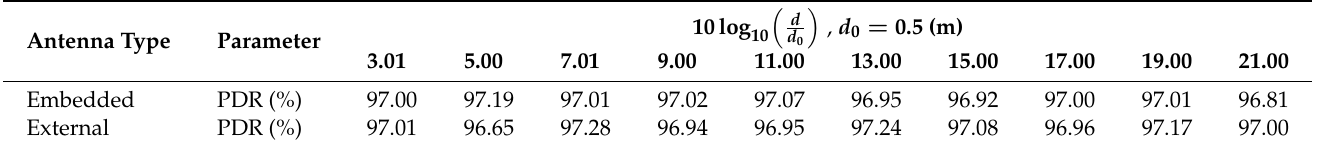
Table 3. Packet Delivery Ratio (PDR) for Line-of-Sight